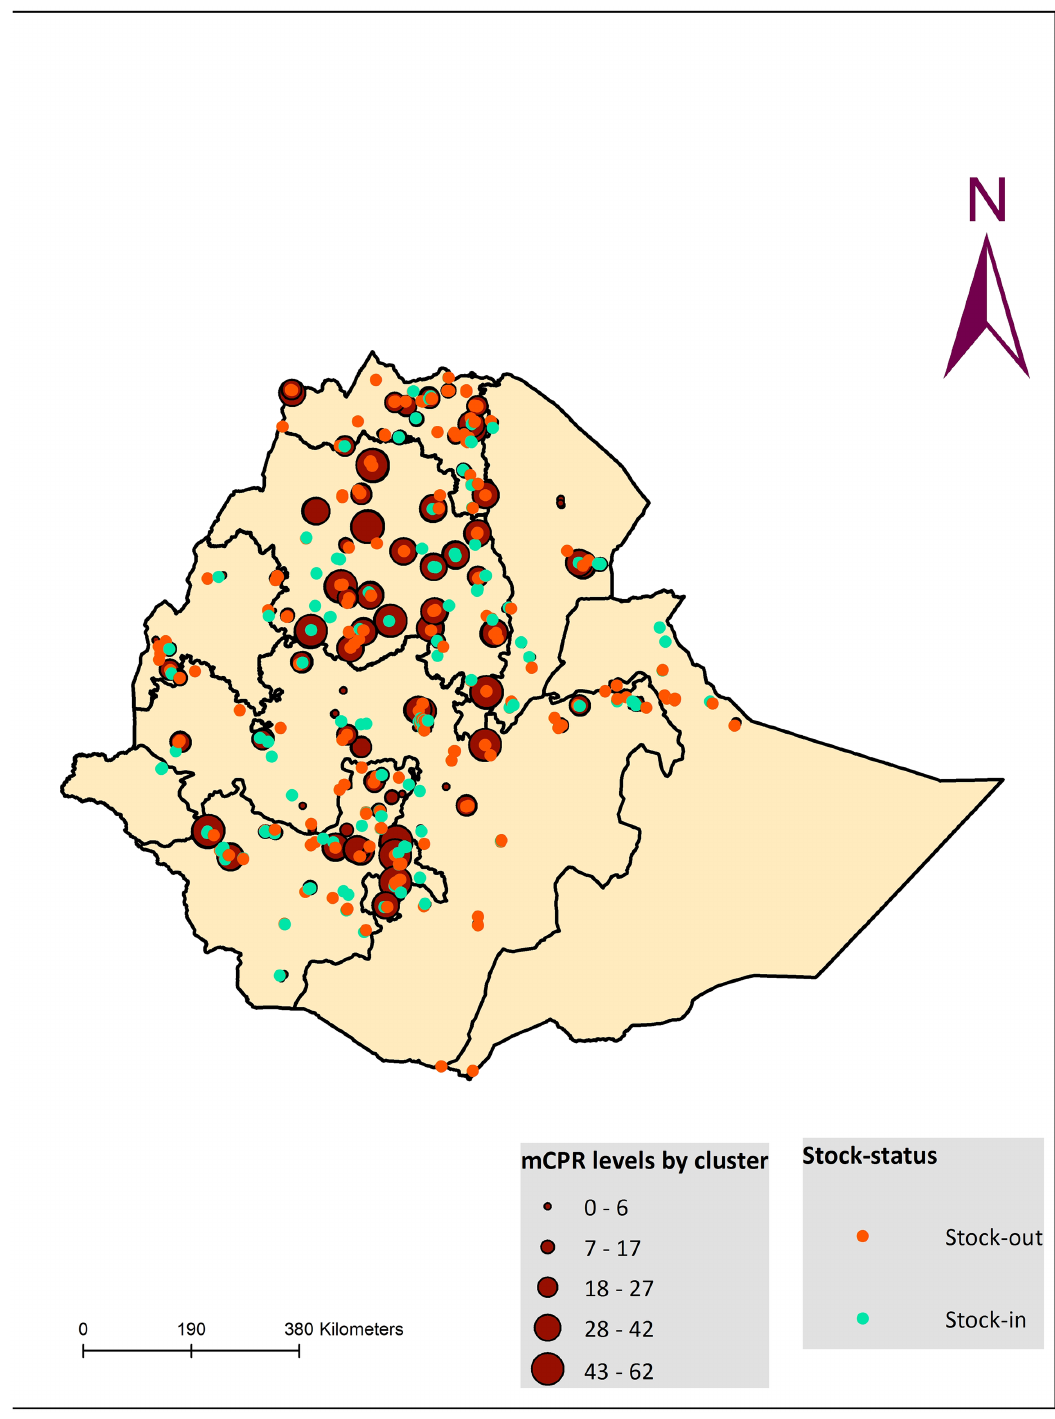
Fig 4. Spatial distribution of facilities with stock-out of contraceptives and clusters according to levels of MCP, 2014.